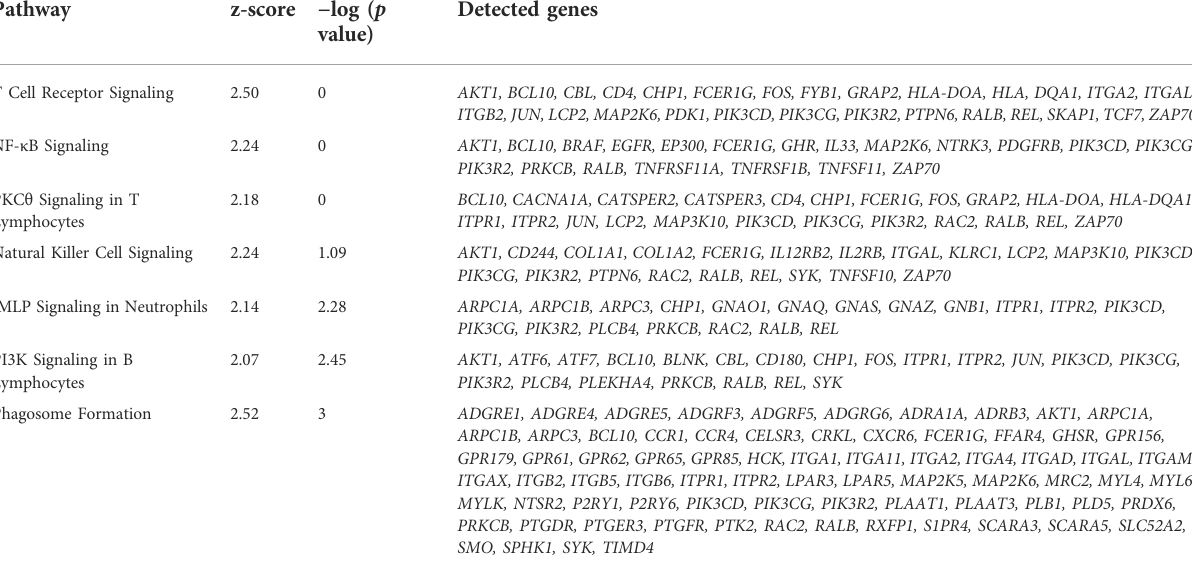
TABLE 1 Immune response and in fl ammation-related activated pathways in VAT versus SAT samples identi fi ed by Ingenuity Pathways Analysis (IPA) from bulk-RNAseq data.